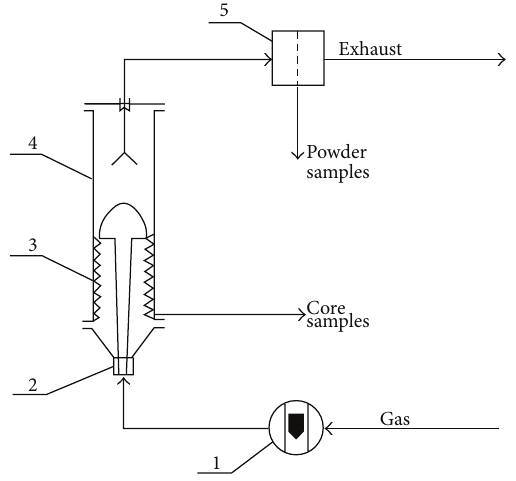
Figure 1: Equipment used for abrasion in a spouted bed. 1: Rotameter, 2: nozzle, 3: abrasive lining; 4: column, 5: filter.